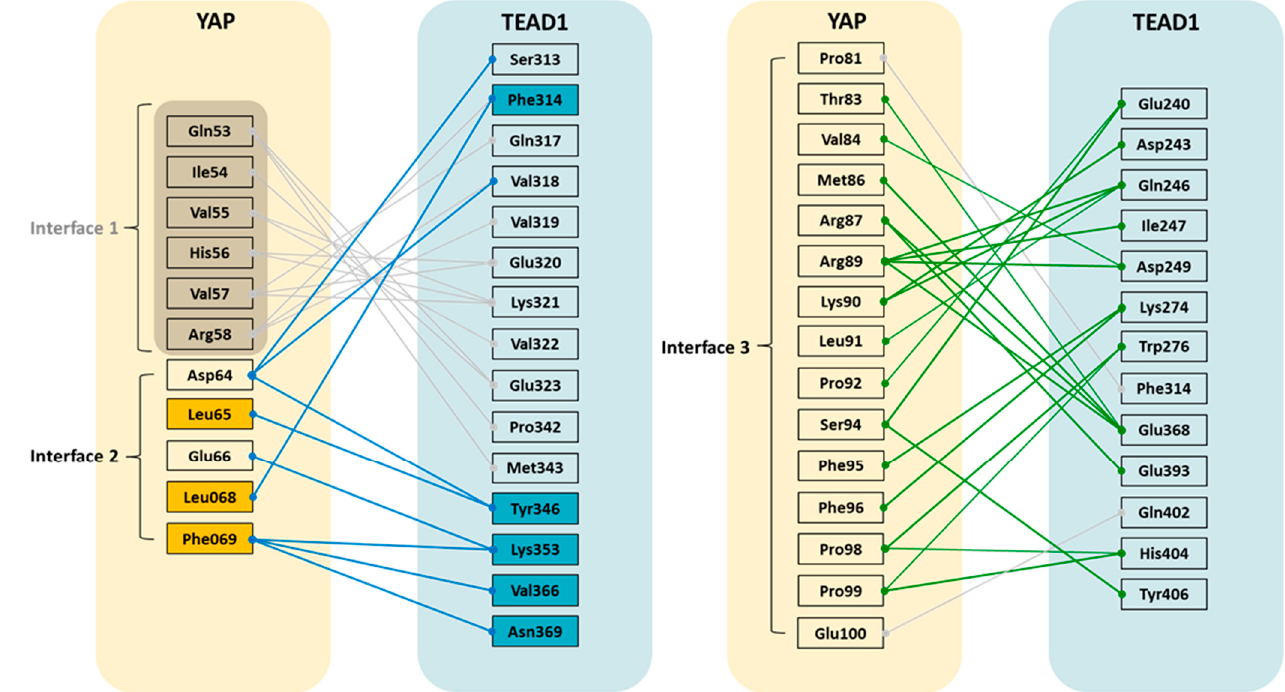
Figure 1. PPIs map of YAP-TEAD1. The 3D-SPIE-based interaction maps consist of interface 2 ( left ) and interface 3 ( right ) YAP–TEAD1 PPIs. The main interactions in the interface 2 of YAP-TEAD1 are shown by blue lines ( left ). The orange box represents the LxxLF motif in YAP, and the blue box represents binding partner residues in TEAD1 for the YAP LxxLF motif. The main interactions in interface 3 are represented by green lines ( right ). Left gray lines indicate interface 1, and right gray lines indicate amino acids excluded from interface 3. All interactions (shown in this map) whose magnitudes are ignored have a tt ractive PIE values more stable than − 3.0 kcal/mol.